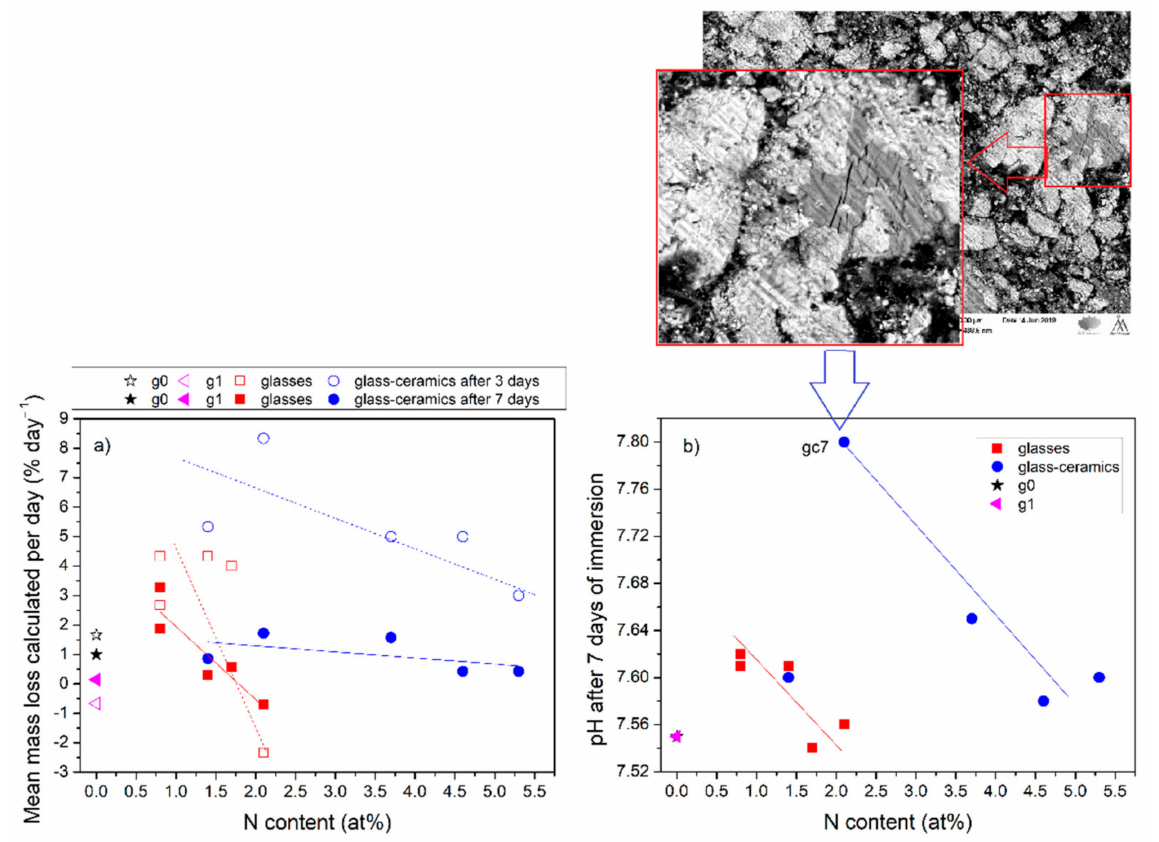
Figure 6. ( a ) Mean % mass loss calculated per day and ( b ) pH values after 7 days of immersion as a function of nitrogen content for glasses and glass-ceramics. SEM micrographs show the enlarged phosphates structures observed for sample